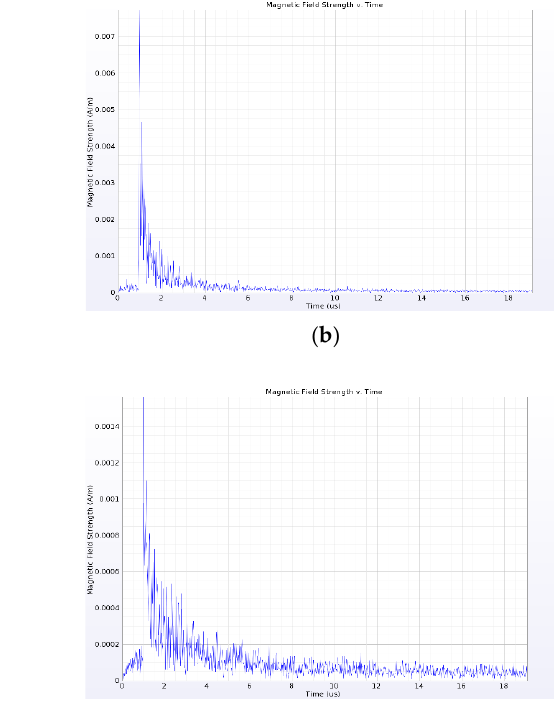
Electric field strength at point sensor 3; ( d ) Electric field strength at point sensor 4.